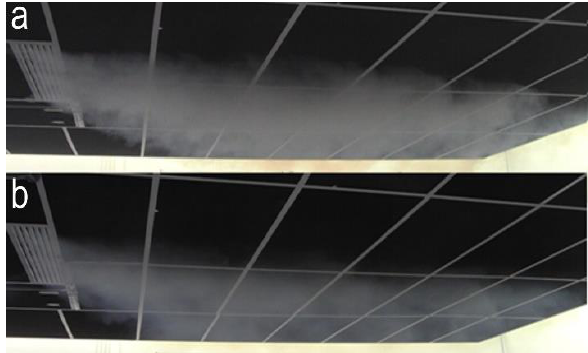
Fig. 7 . Smoke test of the NSAL diffuser with outflow along the